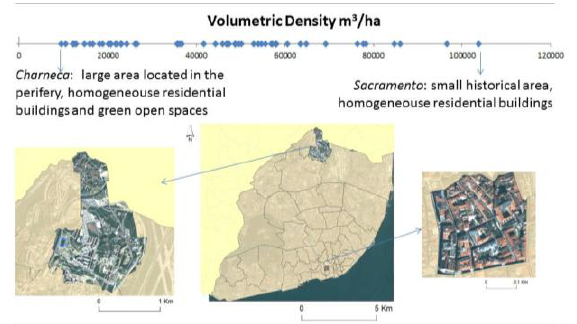
Figure 4. Volumetric Density (m3/ha) in Lisbon city, calculated at the parish-level